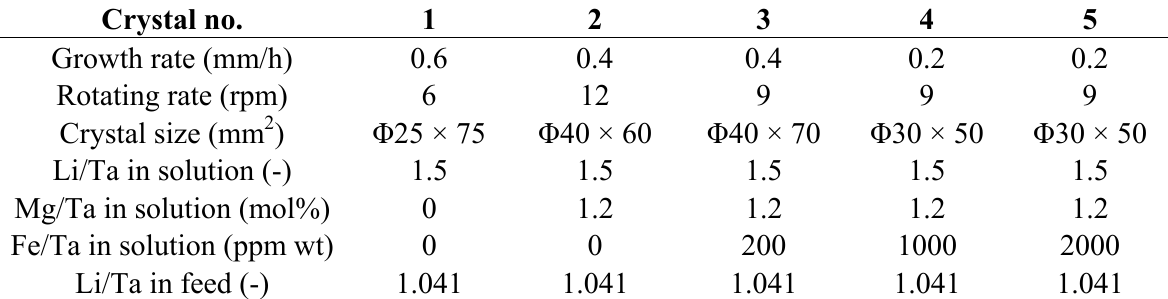
Table 1. Growth conditions of SLT crystals.